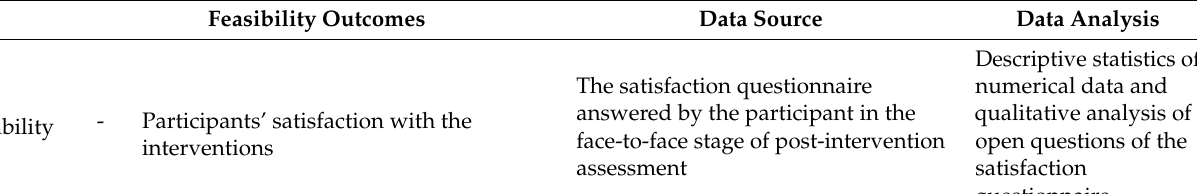
Table 1. Feasibility outcomes, data sources, and data